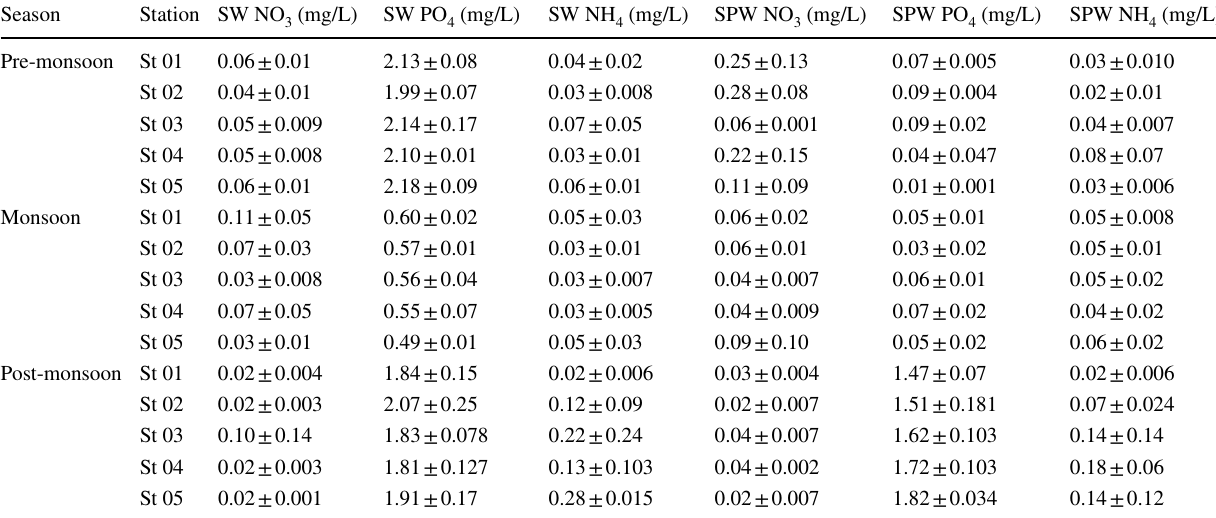
Table 2 Water nutrients in surface and sediment pore water of Passur River estuary, Sundarban waterSeason SW surface water, SPW sediment pore